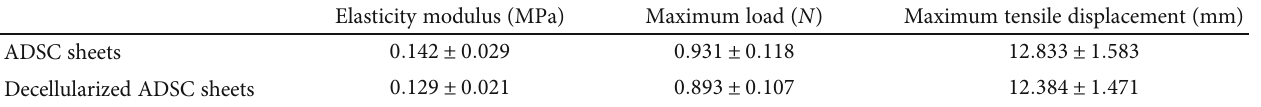
Figure 3: Analysis of retained cytokines and mechanical testing. (a) The gross appearance of decellularized ADSC sheets. (b) ELISA analysis of retained cytokines. The cytokine content, including VEGF, bFGF, and TGF- β , has no statistical di ff erence between in decellularized ADSC sheets and natural ADSC sheets ( P > 0 : 05 ). (c) Comparison of load-displacement curve before and after decellularization. Table 1: The mechanical properties of the decellularized ADSC sheets and ADSC